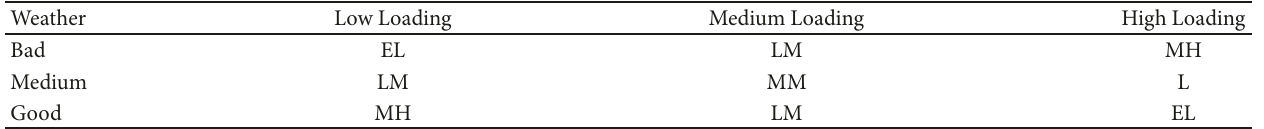
Table 6: Conditional probabilities of network loading levels.